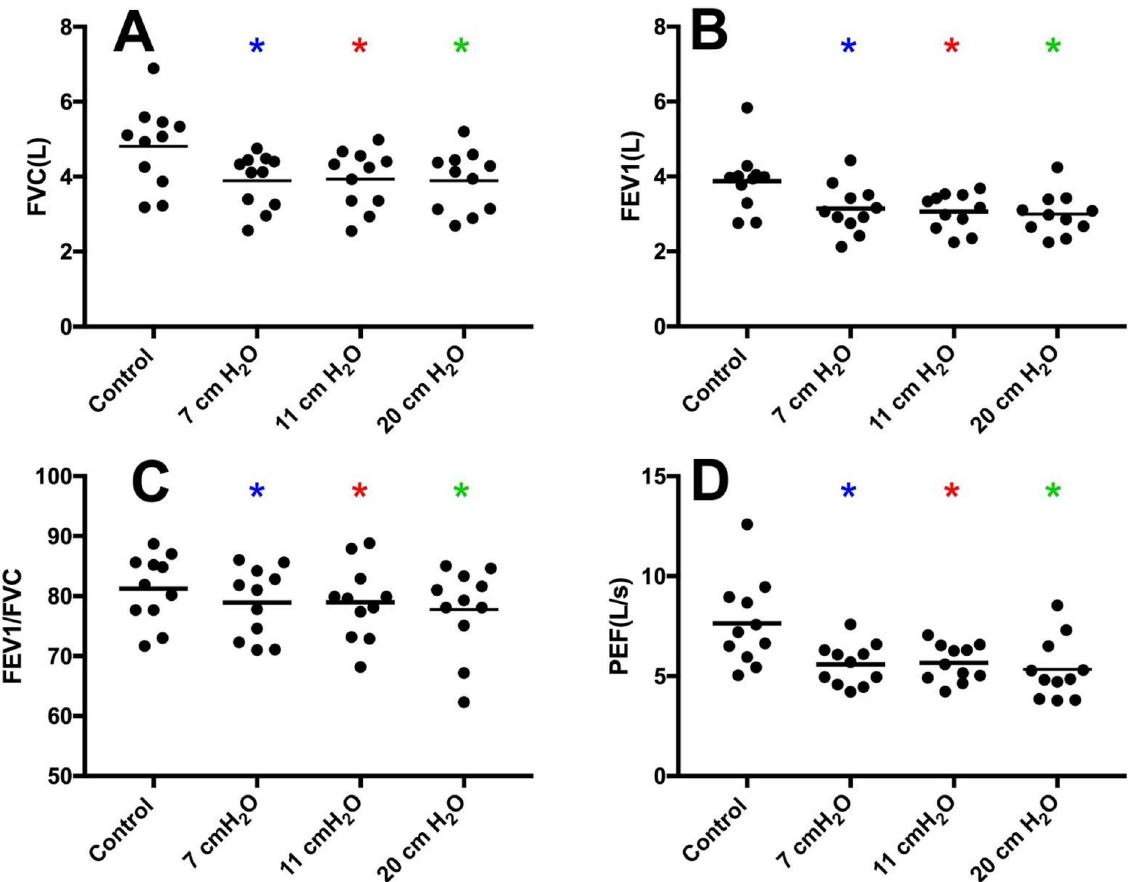
Fig 2. Spirometry data for volunteers with additional imposed expiratory loading of 20 cmH 2 O (n = 11). Panel A: FVC was reduced with expiratory resistance (F[1.4, 14.4] = 23.6, p < 0.05). Panel B: FEV 1 was reduced with expiratory resistance (F[2.0, 20.4] = 17.6, p < 0.05). Panel C: FEV 1 /FVC was reduced with expiratory resistance (F[2.3, 22.6] = 3.9, p < 0.05). Panel D: PEF was reduced with expiratory resistance (F[1.3, 13.2] = 22.0, p < 0.05). � Different from control ( p <